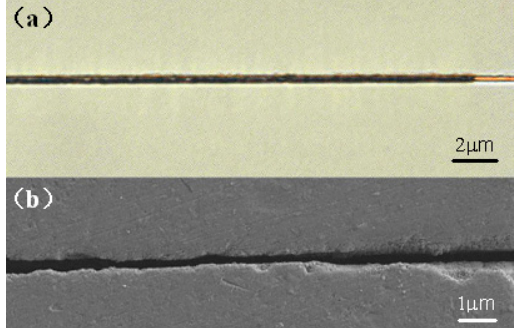
Figure 7. ( a ) Close-up view of submicrometer channels partially filled with water before post-annealing and ( b ) top view SEM image of the inner wall of the sub-micrometer channel written in the porous glass after post-annealing. glass after